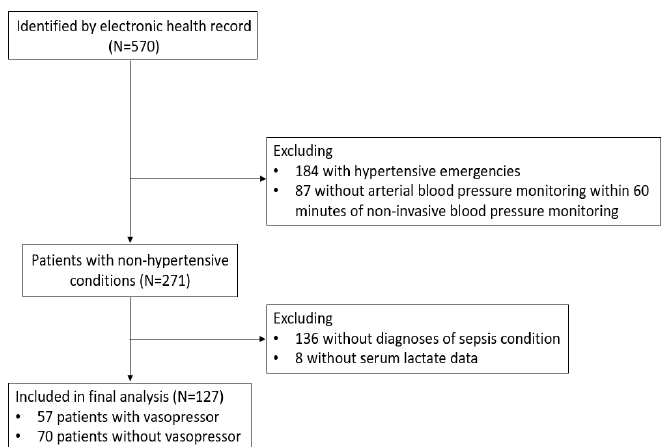
Figure 1. Patient selection diagram. We included 127 patients with sepsis conditions in our analysis.